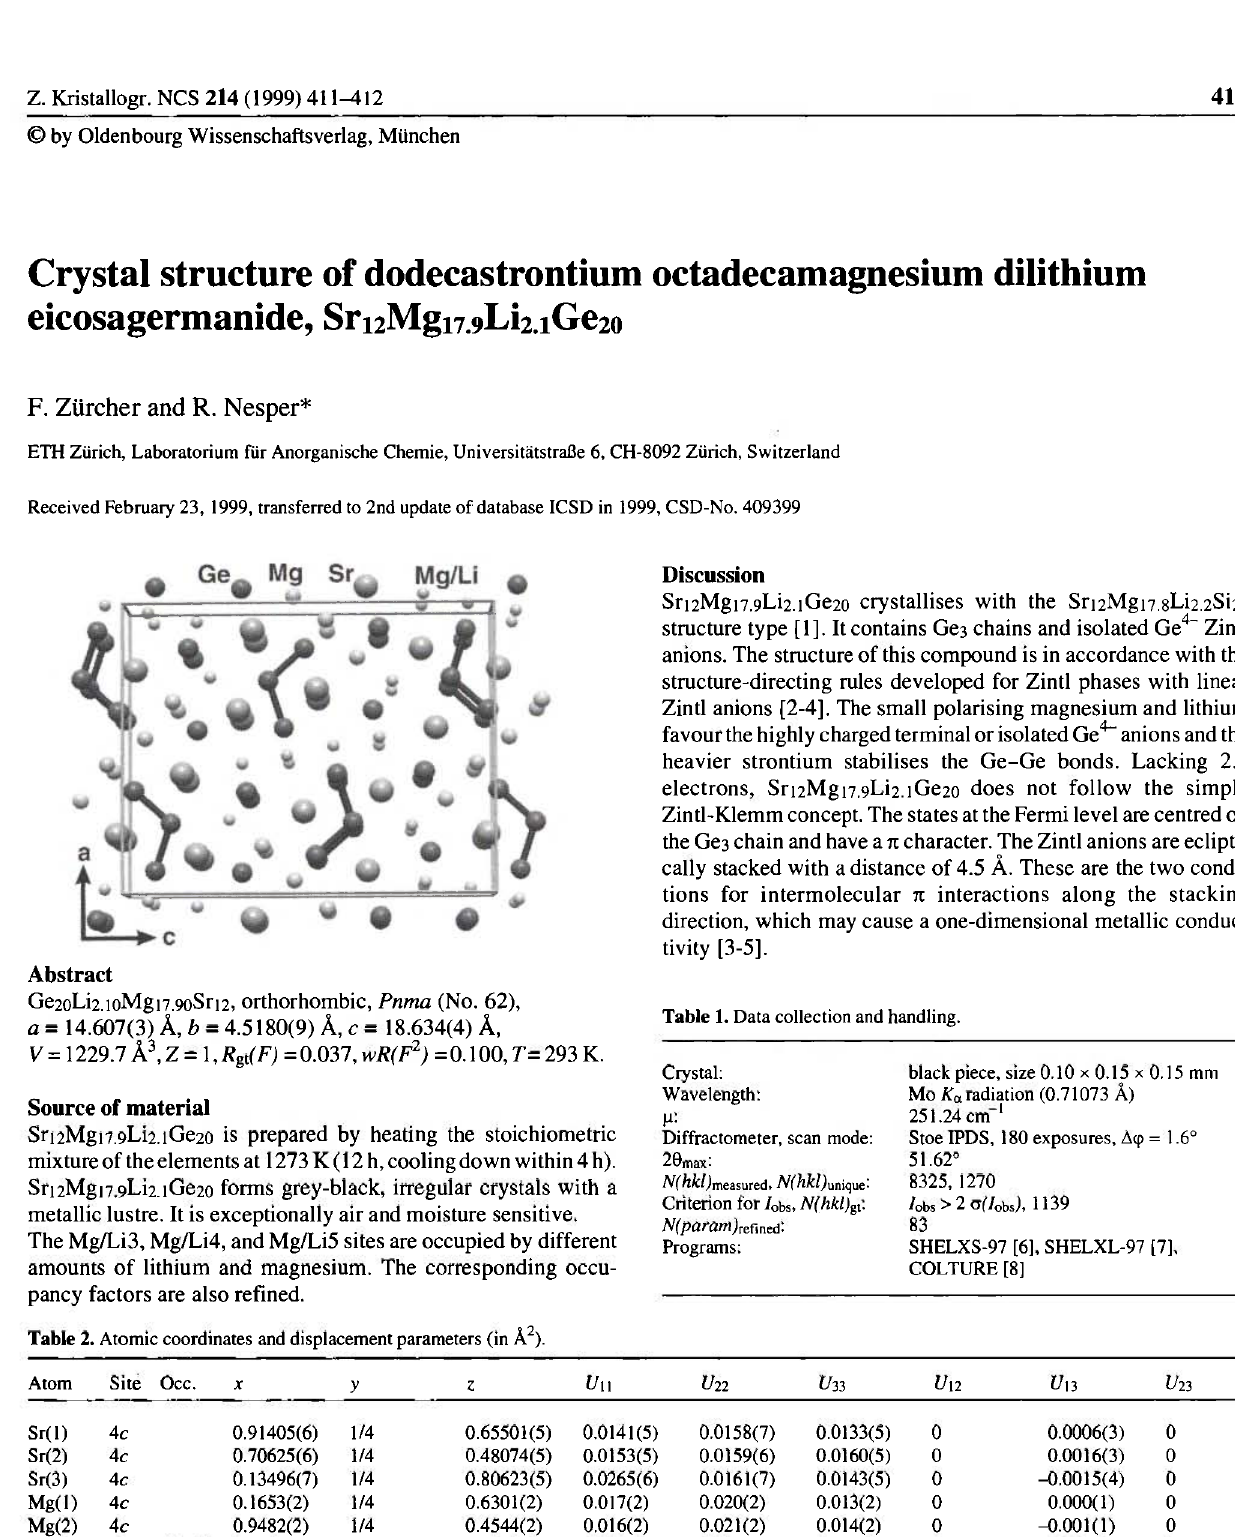
Table 2. Atomic coordinates and displacement parameters (in Ä 2 ). Atom Site Occ.